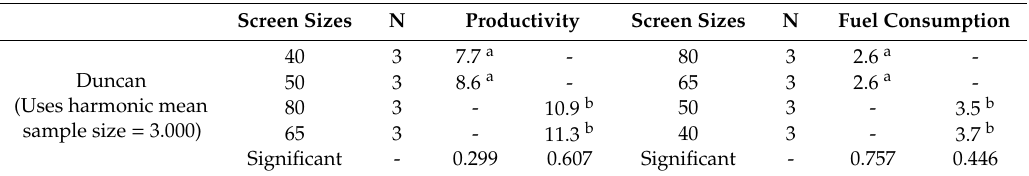
Table 3. Duncan’s multiple range test for the productivity and fuel consumption per odt on screen size. n = 12. Screen Sizes N Duncan (Uses harmonic mean sample size = 3.000)